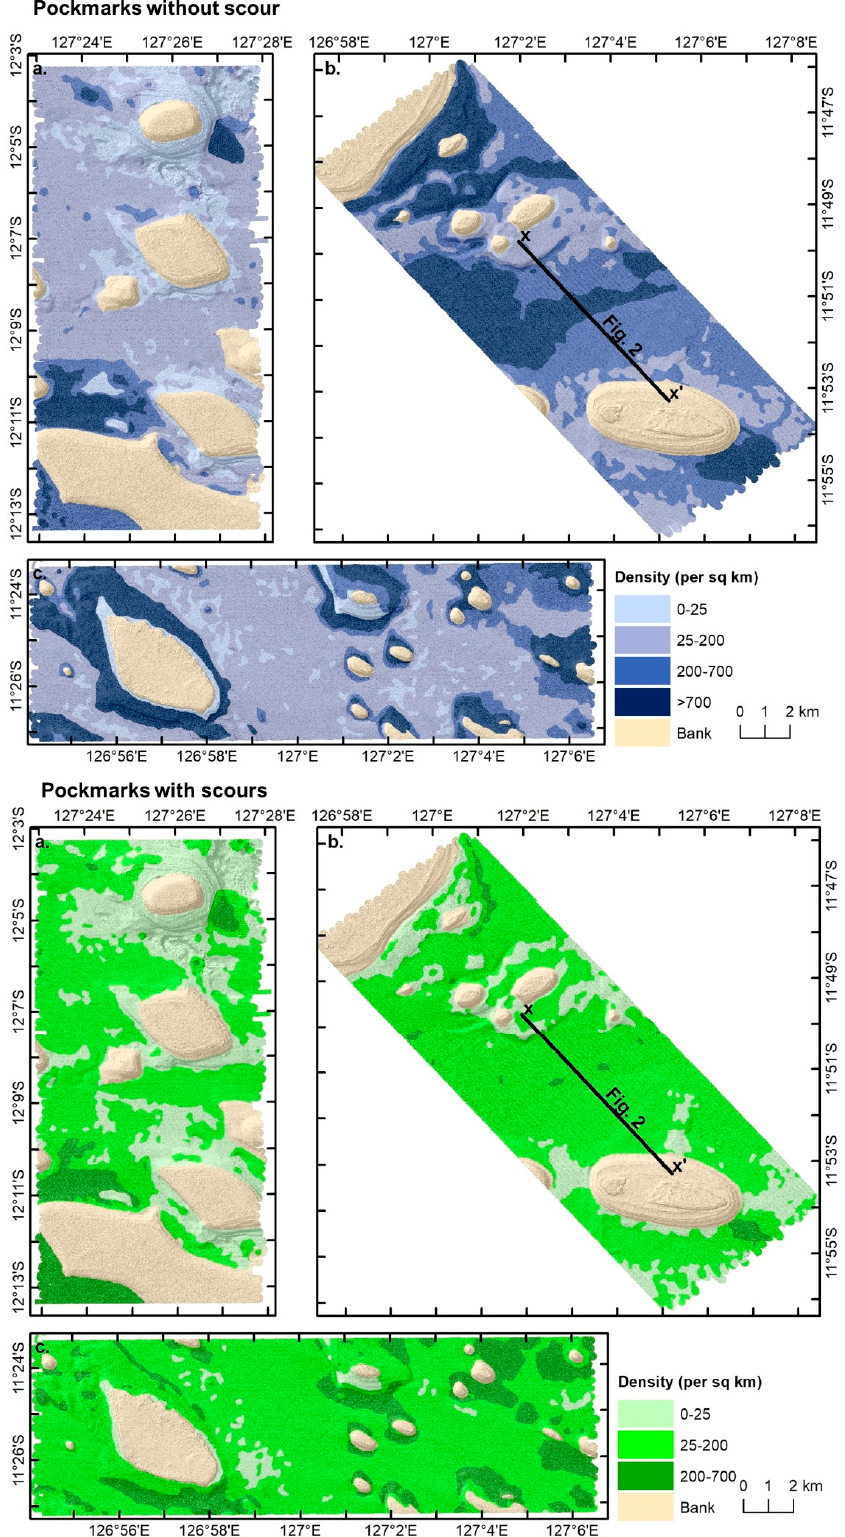
3 Figure 6. Density distribution of pockmark without scour (to; blue shades) and with scours (bottom; green shades) within the three survey areas (( a ) Area 1, ( b ) Area 2, and ( c ) Area 3). The location of the sub-bottom profile presented in Figure 2d is also displayed on b. to indicate the location of the buried paleochannel within the cross-shelf valley of Area